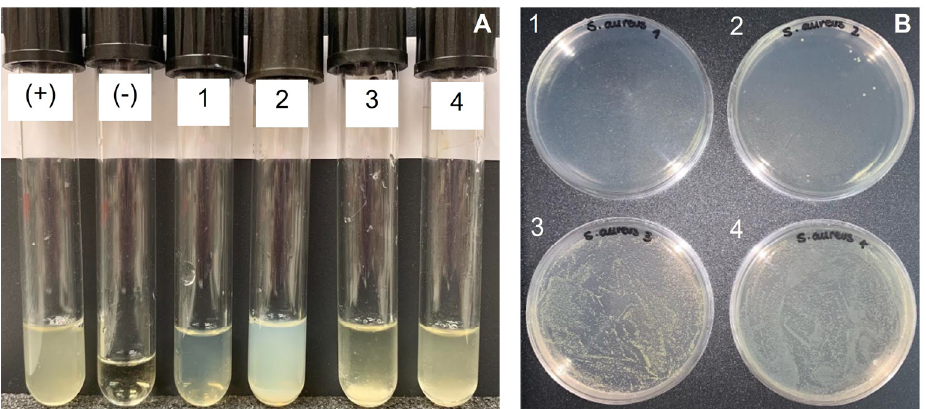
Figure 9. Antimicrobial activity of S. entomon chitosan in a broth macrodilution assay against S. aureus ( A ). Growth on plates ( B ). Tube 1: 3.34 mg/mL, tube 2: 1.11 mg/mL, tube 3:0.37 mg/mL and tube 4: 0.125 mg/mL.